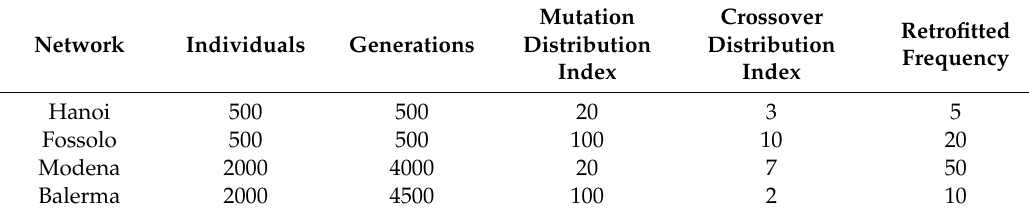
Crossover Mutation Retrofitted Distribution Distribution Frequency Index Index